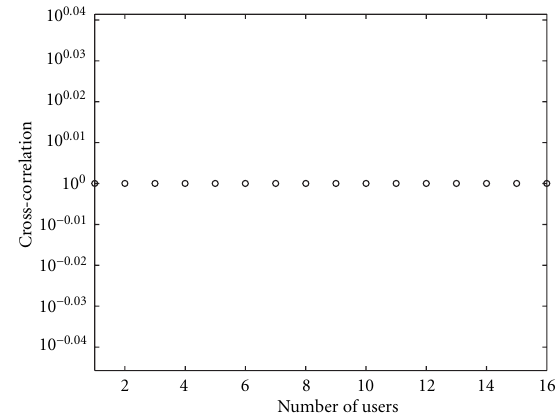
Figure 1: The cross-correlations between the normalized receiver filter of user 1 and its normalized received temporal-spreading se- quences is